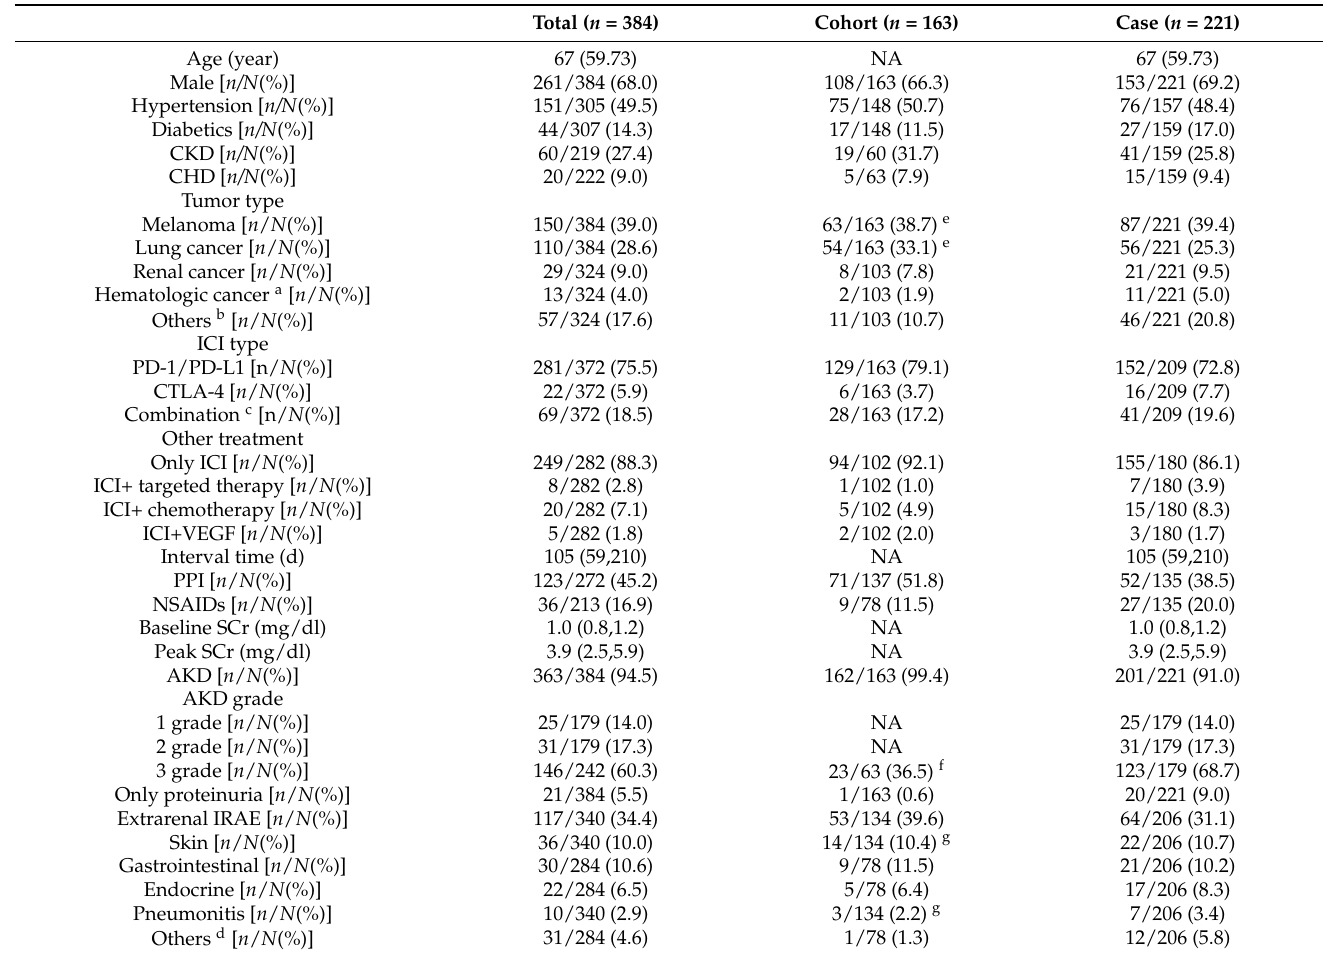
Table 1. Summary of baseline and clinical characteristics of the total group of patients with biopsy- proven kidney